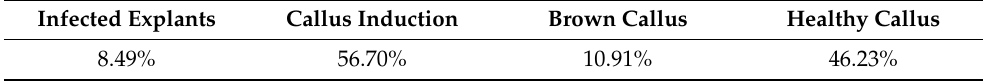
Table 1. Callogenesis rate of leaf explants derived from whole plants.